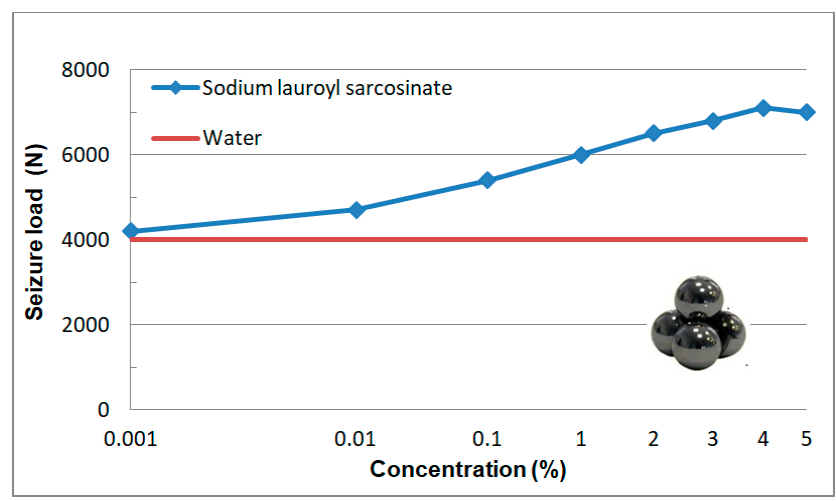
Figure 11. Dependence of seizure load as a function of SLS concentration in aqueous solution. Solid line describes P oz values for water (4000 N).